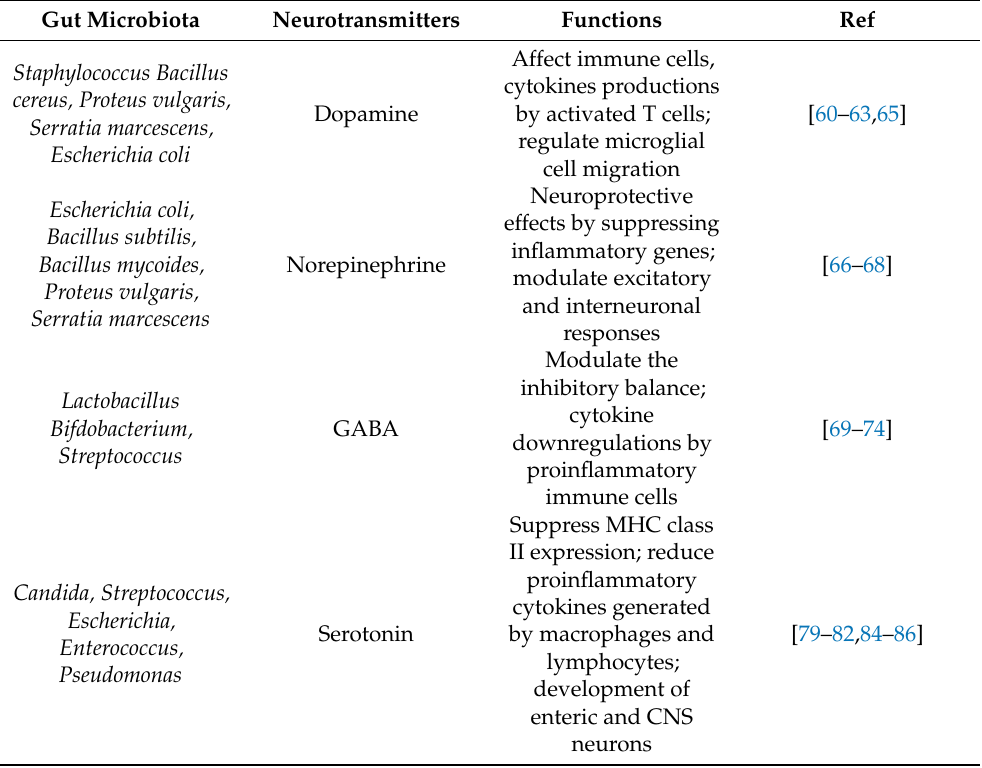
Table 2. Gut microbiota-derived neurotransmitters and their potential functions in brain